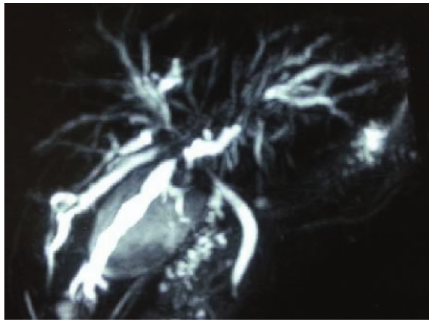
Figure 3: Multiple stricture and dilation of intrahepatic bile ducts.